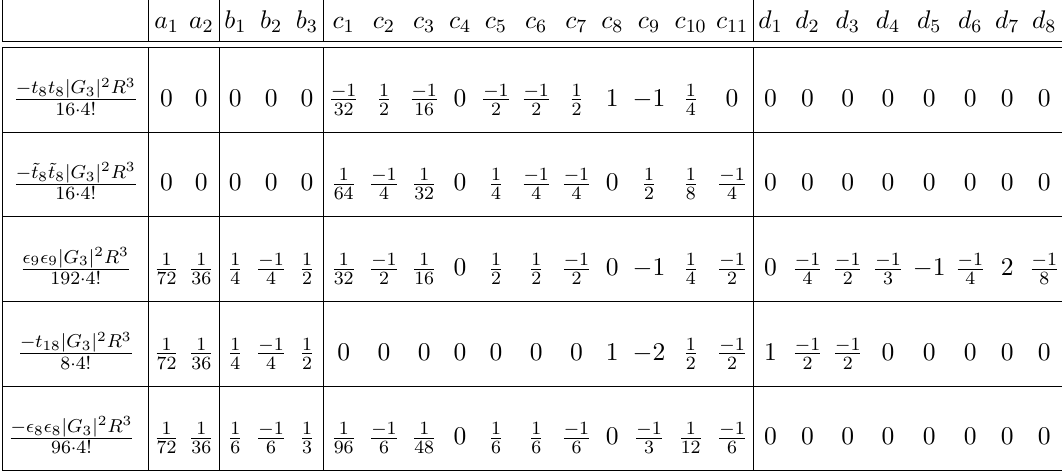
Table 1: Decomposition of index structures for | G 3 | 2 R 3 in the 24 component basis for R 3 defined in appendix